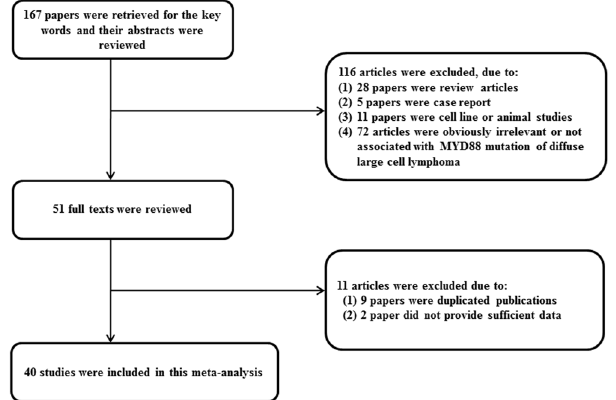
Figure 6. Article selection flow